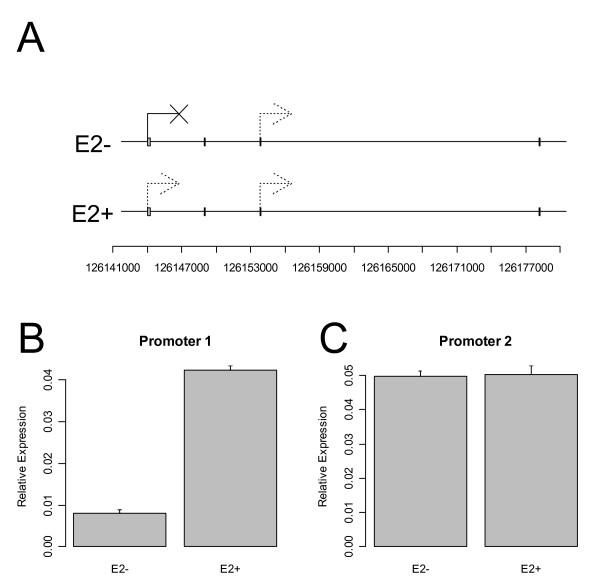
Shown here are the first four exons of the gene NCOA7, spanning a region of roughly 32 kb (A). Exon 3 is spliced out of the transcript initiated at Exon 1, but Exon 4 is common to both transcripts. The ChIP-chip microarray analysis indicated that the first promoter is inactive in the control experiment, but is activated with E2 treatment at a low level, a result that is verified by qRT-PCR results (B). The second promoter was predicted to be active at a low level with and without E2 treatment, which again was verified (C). Error bars indicate standard errors from the mean for three replicates.